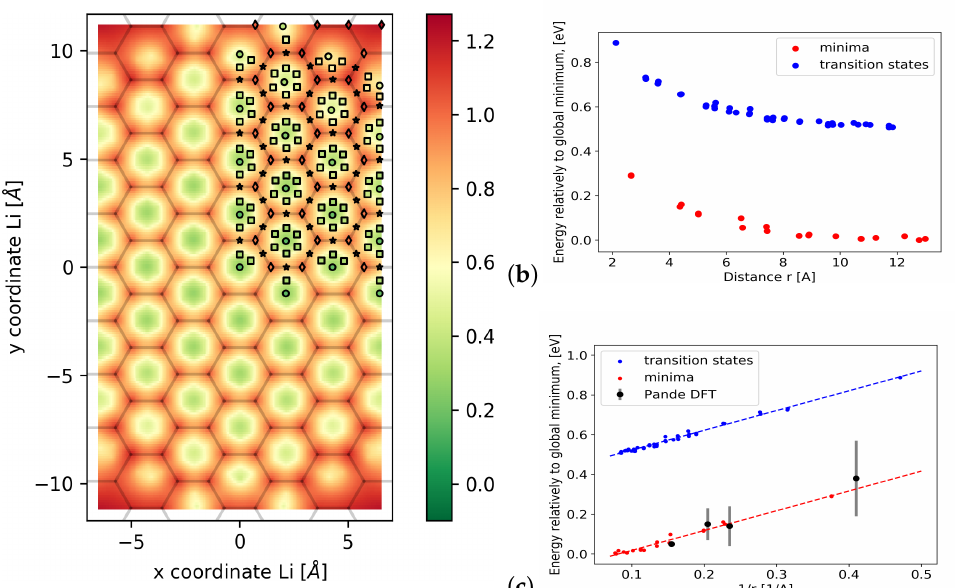
Figure 3. ( a ) Calculated potential energy surface for a freely moving Li-ion with respect to a second fixed ion in the corner of the unit cell (see main text for details of the structural model). Color gradient in eV relative to the global minimum at (0/0). Circles are local minima, diamonds are local maxima, stars are transition states (calculated with the cNEB method), and squares are additional images from the NEBs—all of which have been used for the 2D fit; ( b ) Potential energy depending on the distance between the two Li-ions (blue dots are the transition positions, red dots are the ground states); ( c ) Potential energy depending on the reciprocal distance—clearly showing the Coulombic nature of the interaction, which agrees with